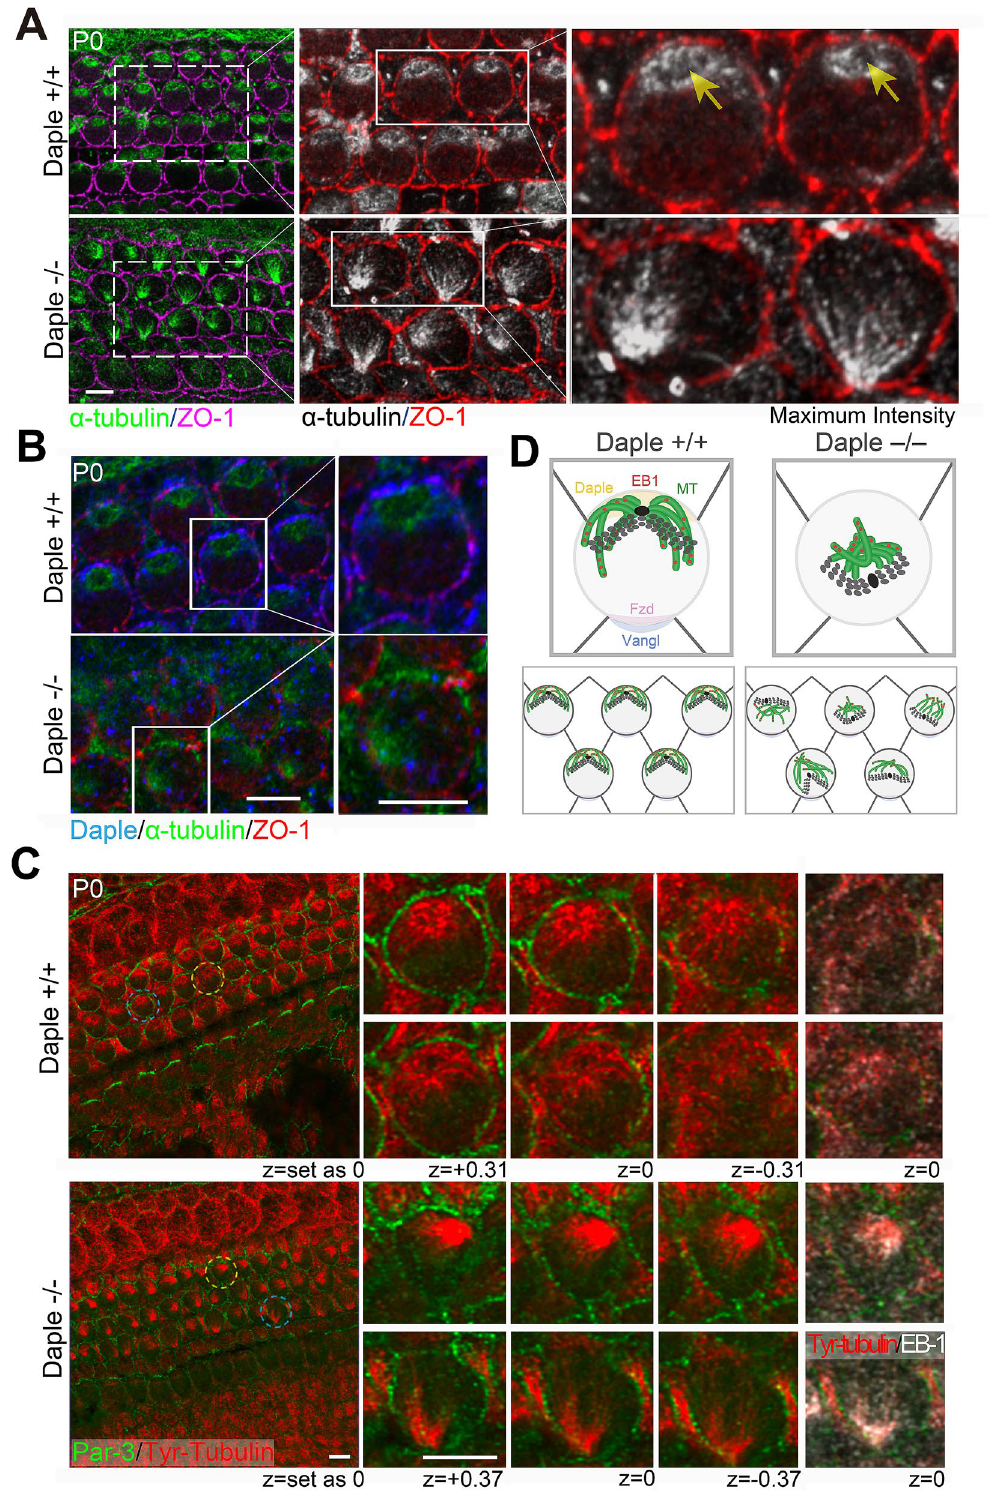
Figure 4. Microtubules and related protein expression in hair cells (HCs) of the organ of Corti (OC) in Daple −/− mice. ( A ) Microtubules were spread from the pericentriolar area (arrows) to outer hair cell (OHC) cortexes, mainly in lateral areas in Daple +/+ P0 mice. Microtubules were disorganized or aggregated around pericentriolar areas in Daple −/− P0 mice. ( B ) Daple and microtubule distribution in Daple +/+ P0 mice. Daple surrounded the microtubules in the centrosomes of the HCs of Daple +/+ mice. Some non-specific staining was observed, but ring-like staining was not detected in Daple −/− HCs. ( C ) We compared a z-series of images against microtubules/EB-1. EB-1 was concentrated in microtubule aggregations in many Daple −/− HCs. ( D ) Schematic of apical microtubule networks in HCs of Daple WT mice compared to those of Daple KO mice. Scale bars: A, B, C, 5